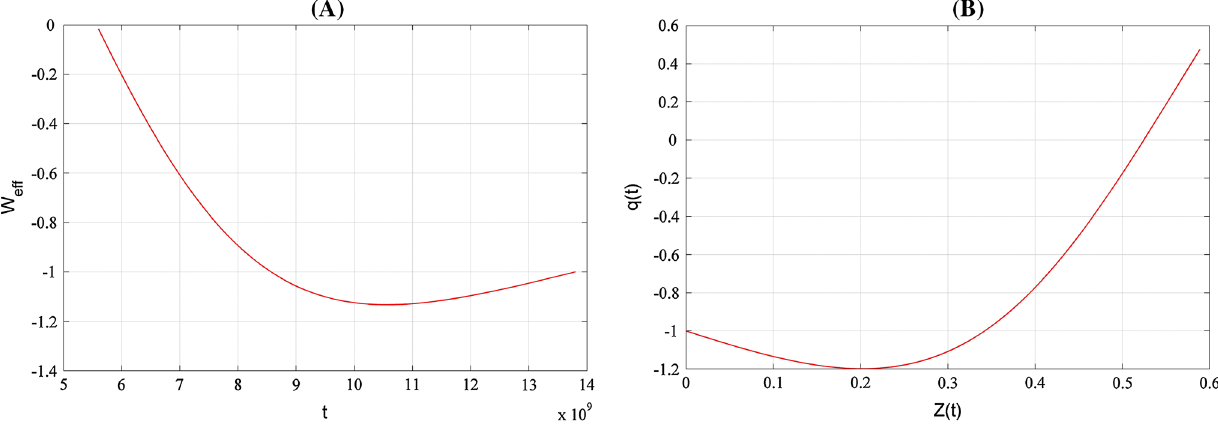
Fig. 4 Plots a and b indicate the state parameter W eff and deceleration parameter q versus redshift z at the time range [5.6Gyr, 13.8Gyr], respectively deceleration parameter is measured to be q 0 = − 1 . 00, and at the time t ac . = 6 . 294 Gyr , we have q ( t ac . ) = 0, so the accel- at about half the age of the